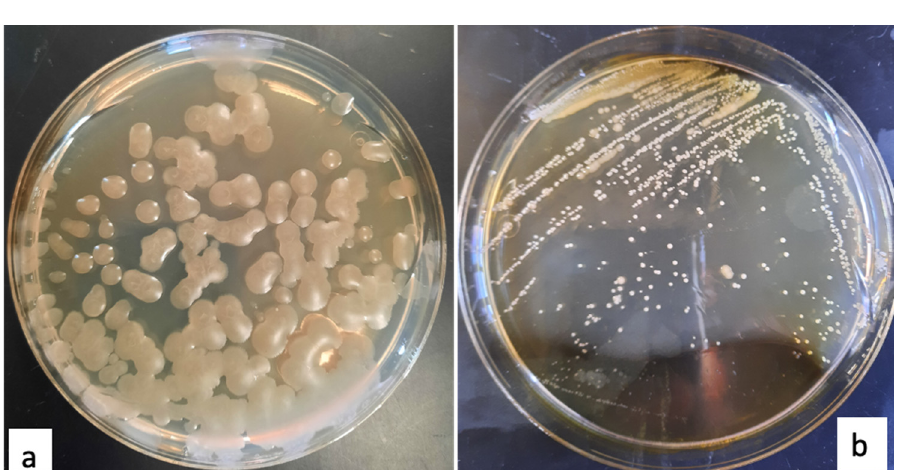
Figure 5. Pure cultures of isolated bacteria ( a ) 1B and ( b ) 2D1 resulted as PHB positive. At the naked eye, both PHB positive strains formed regular white colonies, translucent, with a smooth surface. However, while strain 1B (Figure 5a) formed viscid clustered colonies with a diameter between 3 to 5 mm, the strain 2D1 (Figure 5b) grew into isolated dry colonies with a smaller diameter between 0.5 to 1 mm. Moreover, both PHB producers were identified as Gram-negative bacteria, and the bacterial red color appreciated at 100× magnification power can be observed in Figure 6. Figure 6. Gram staining: 1B ( a ) and 2D1 ( b ) appear colored in red, hence classified as Gram-negative bacteria. Among the biopolymers, the PHB is the most characterized and synthesized by dif- ferent Gram-positive Bacillus sp., such as Bacillus megaterium, B. subtilis, and B. thurin- giensis , but also by Gram-negative bacteria such as Cupriavidus necator , Azotobacter vine- landii , and Pseudomonas mendocina [9]. Unlike Gram-positive species, the Gram-negative species produce endotoxins in the outer membrane of the lipophilic granules. Unfortu- nately, this cellular mechanism represents a disadvantage not conducive for the medical field applications of PHB synthesized by Gram-negative bacteria, since the high cost for the product purification makes a large-scale production difficult [20]. From this perspec- tive, further work will be necessary in this study to characterize the biopolymer synthe- tized by the two Gram-negative isolated strains to better envision its possible application. 3.4.2. Biochemical Characterization Using the Bergey’s Manual of Determinative Bacteriology and the API 20E system (Biomerieux), the two strains 1B and 2D1 were classified up to the genus level, based on morphological and biochemical properties (Figure 7). While 2D1 showed fermentation properties towards glucose, sucrose, lactose, and maltose, 1B was capable of fermenting the majority of the carbohydrates tested: Glucose, mannose, inositol, sorbitol, sucrose, amygdaline, arabinose, lactose, maltose, and fructose (Figures 7 and 8). Both strains 1B and 2D1 were identified as oxidase negative (Figure 9), while only the 2D1 was urease